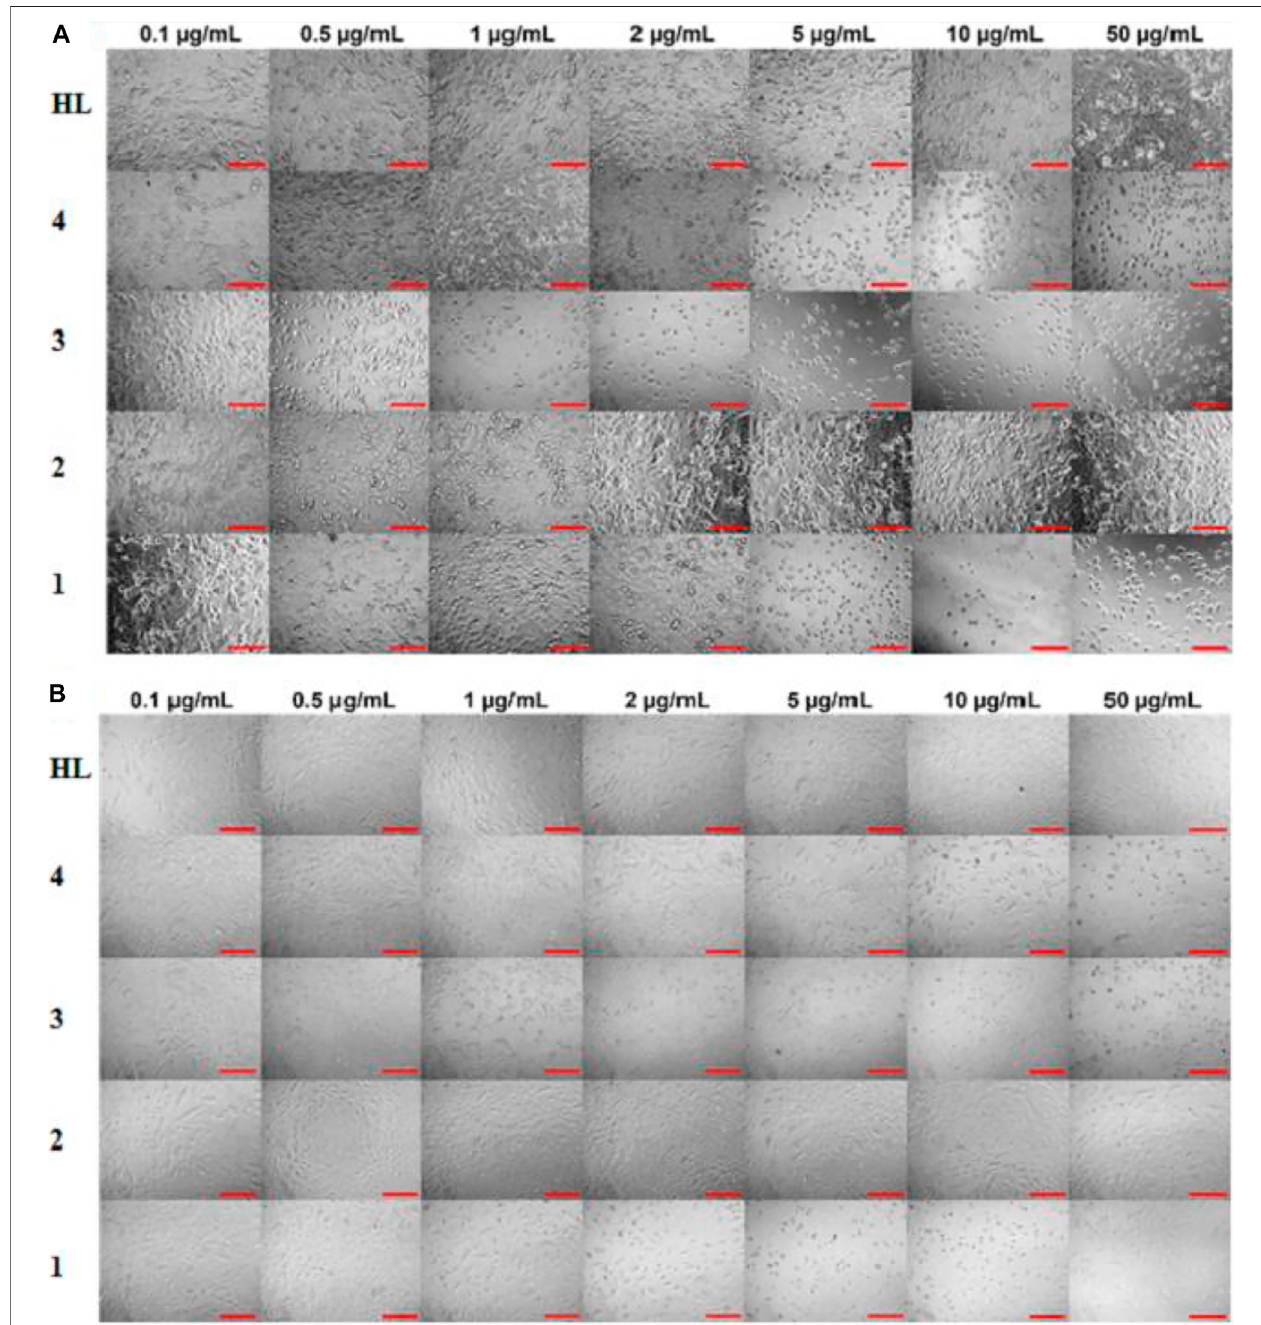
FIGURE 6 | Effect of ligand acid ( HL ) and complexes 1 – 4 on morphology of (A) A549 and (B) MRC-5 for 48 h. The scale bar is 100 µm.